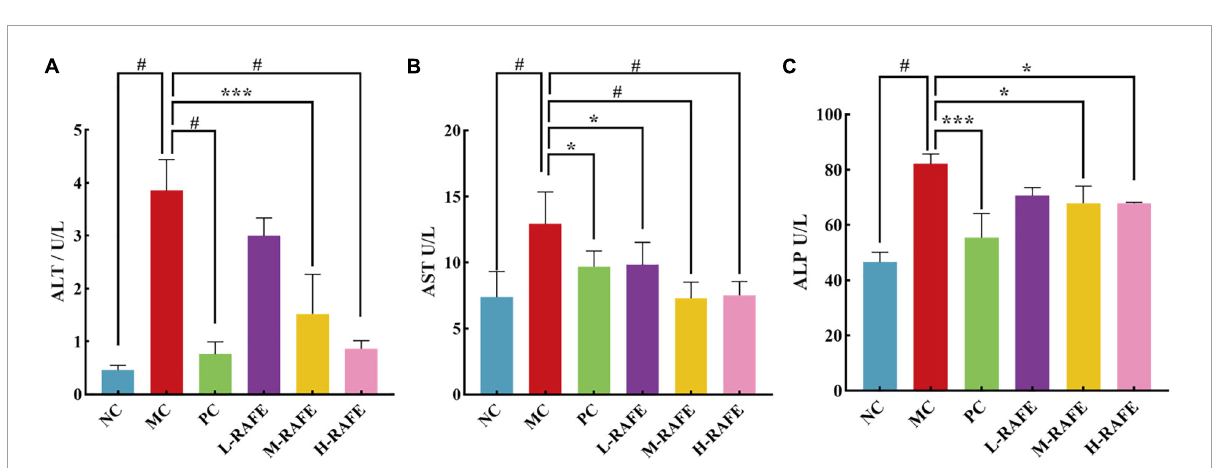
FIGURE4 Effect of RAFE on serum biochemical parameters in mice. (A) ALT, (B) AST, and (C) ALP. Data are expressed as the mean ± SD ( n = 4 or 6) * P < 0.05, *** P < 0.001, # P < 0.0001, compared with the pathological group.